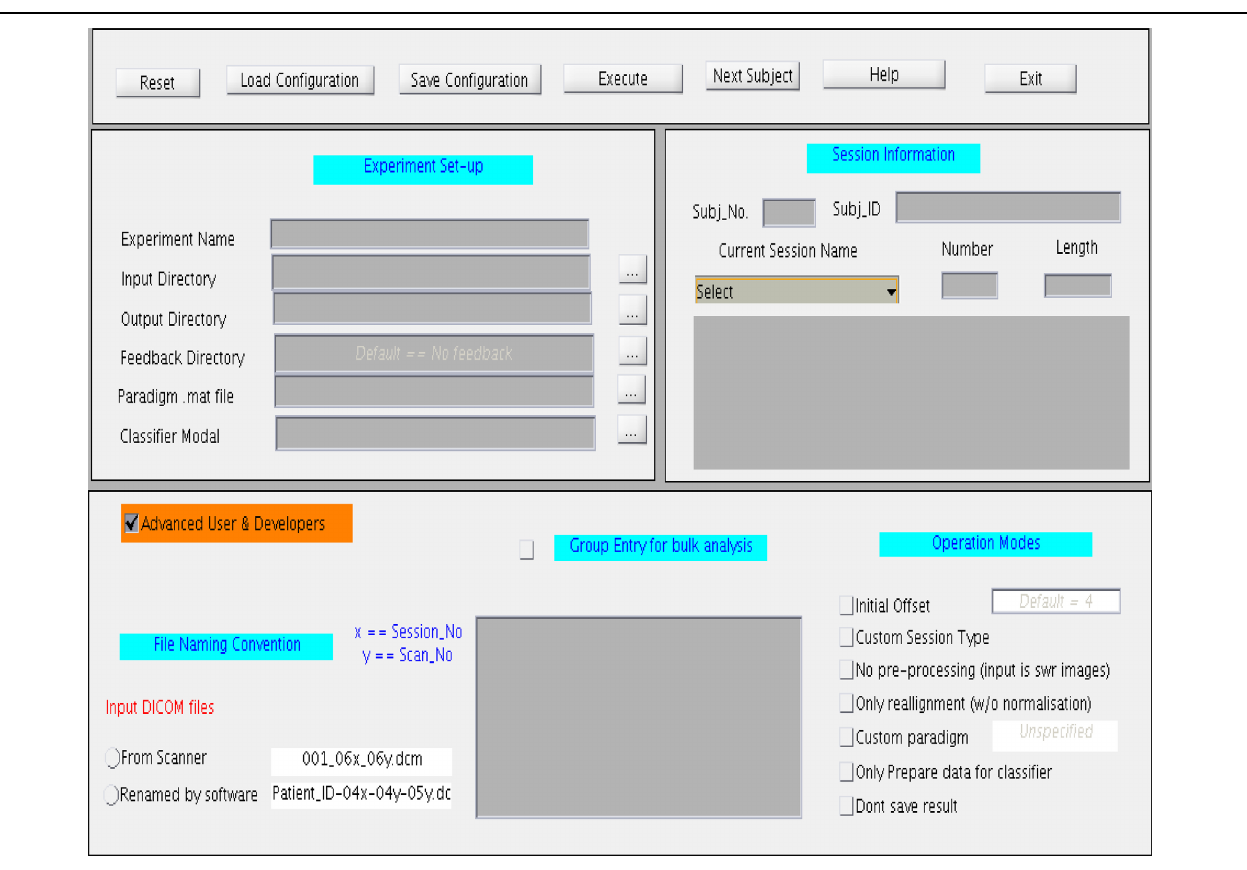
FIGURE 7 | Graphical User Interface (GUI) for the online subject-independent and subject-dependent classification. The GUI is divided into three different sections namely “Experimental setup,” “Session information,” and “Advance User and Developers”.